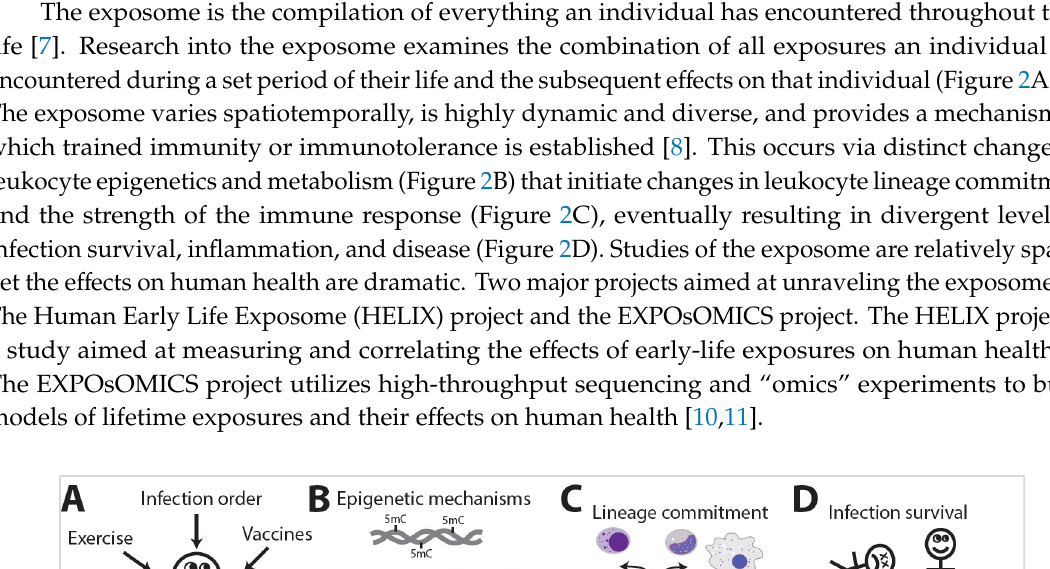
Figure 2. The effect of the exposome on innate immunity. ( A ) The order of exposure to external stimuli can have an important effect on innate immunity. ( B ) These stimuli elicit various epigenetic and metabolic changes that in turn dictate ( C ) lineage commitment and the strength of the innate immune response, which ultimately determine ( D ) the health outcome of the affected individual. The blue and orange lines in (C) denote innate immunity activation (blue line) versus tolerization (orange line). Before an individual is born, they show evidence of epigenetic reprogramming because they are exposed to many stimuli encountered by their mother while also inheriting maternal epigenetic